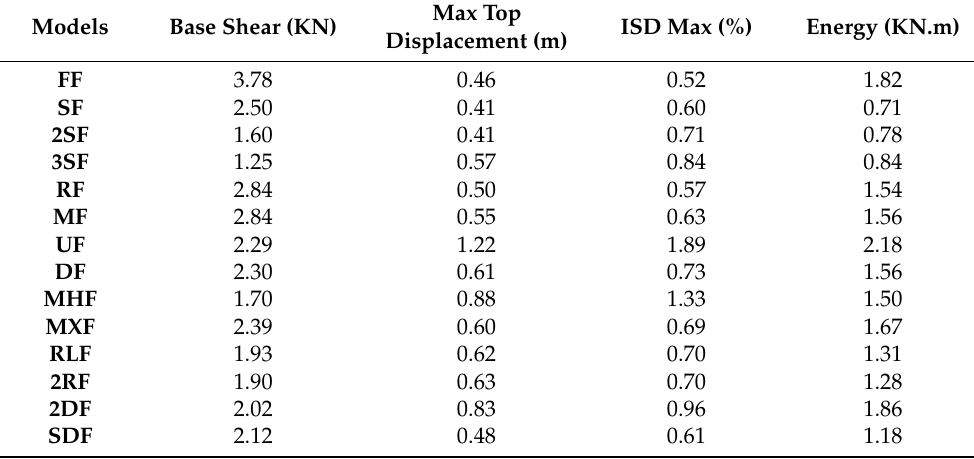
Table 6. The values of maximum top displacement, maximum base shear, maximum inter-story drift and the energy for all models are attributed to their corresponding values in the bare frame